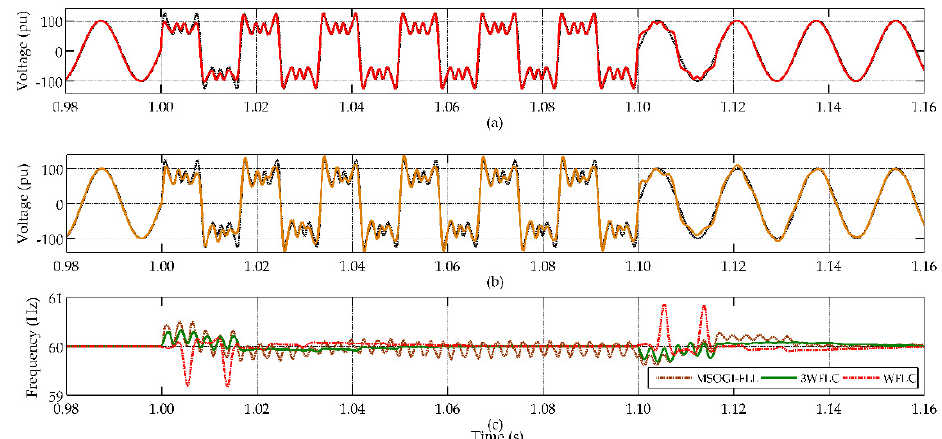
Figure 5. Results from simulation scenario 3, harmonic injection tracking. ( a ) SDFLC harmonic voltage 图 5 tracking; ( b ) MSOGI-FLL voltage tracking. ( c ) Frequency transients in harmonic